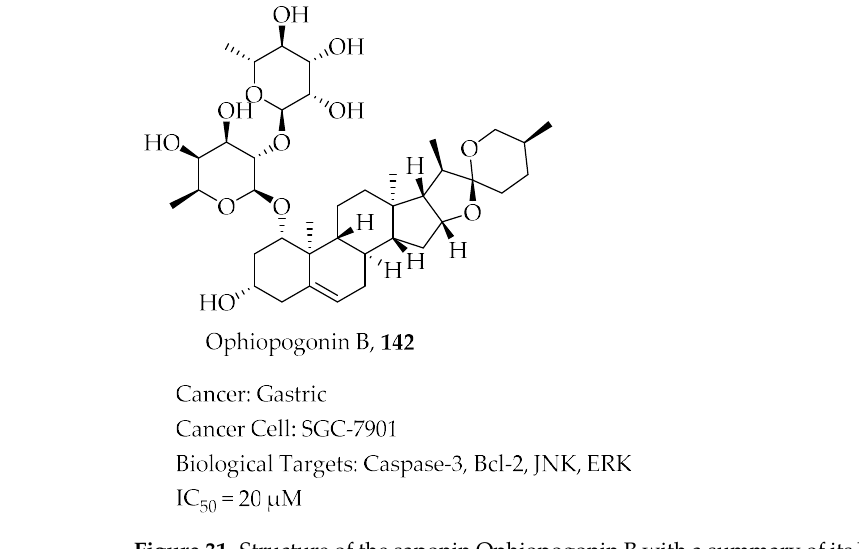
Figure 31. Structure of the saponin Ophiopogonin B with a summary of its biological activity to- wards selected cancer targets.